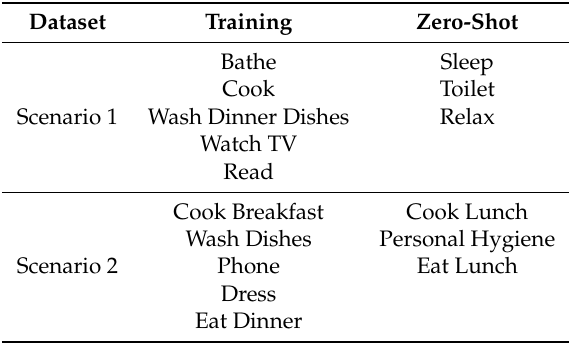
Table 5. Training vs. zero-shot classes